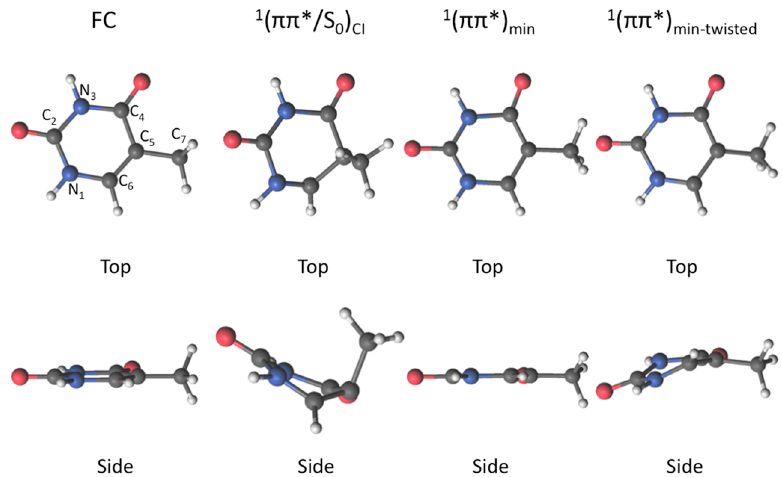
Figure 1. Geometry and labeling for the Franck-Condon region and the different structures found in thymine along its 1 ( ππ *) lowest-lying bright excited state potential energy hypersurface.